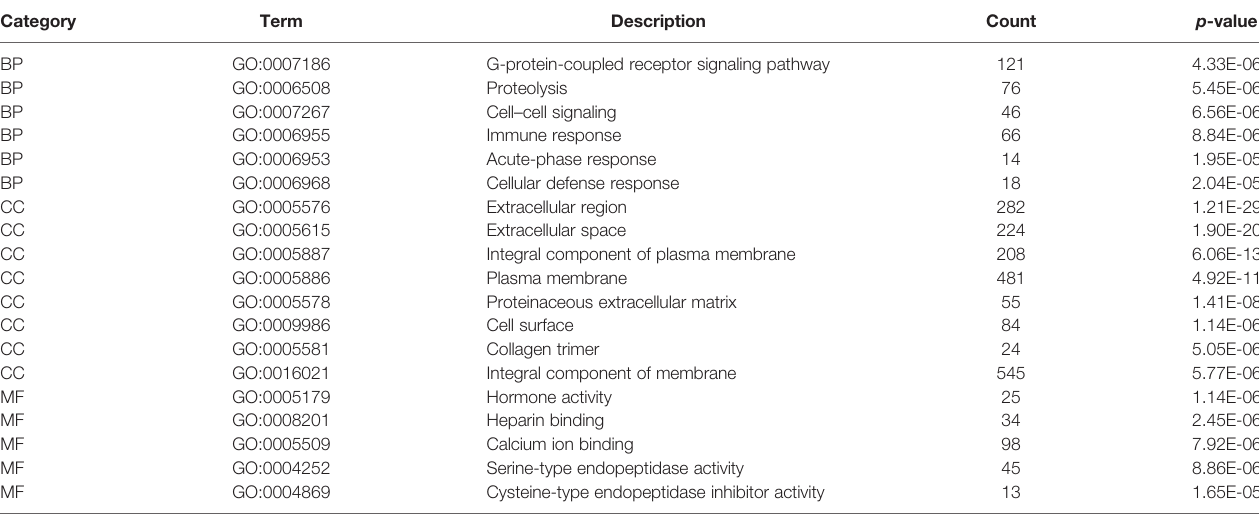
TABLE 1 | GO functional enrichment analysis of 1,855 DEGs associated with ccRCC.